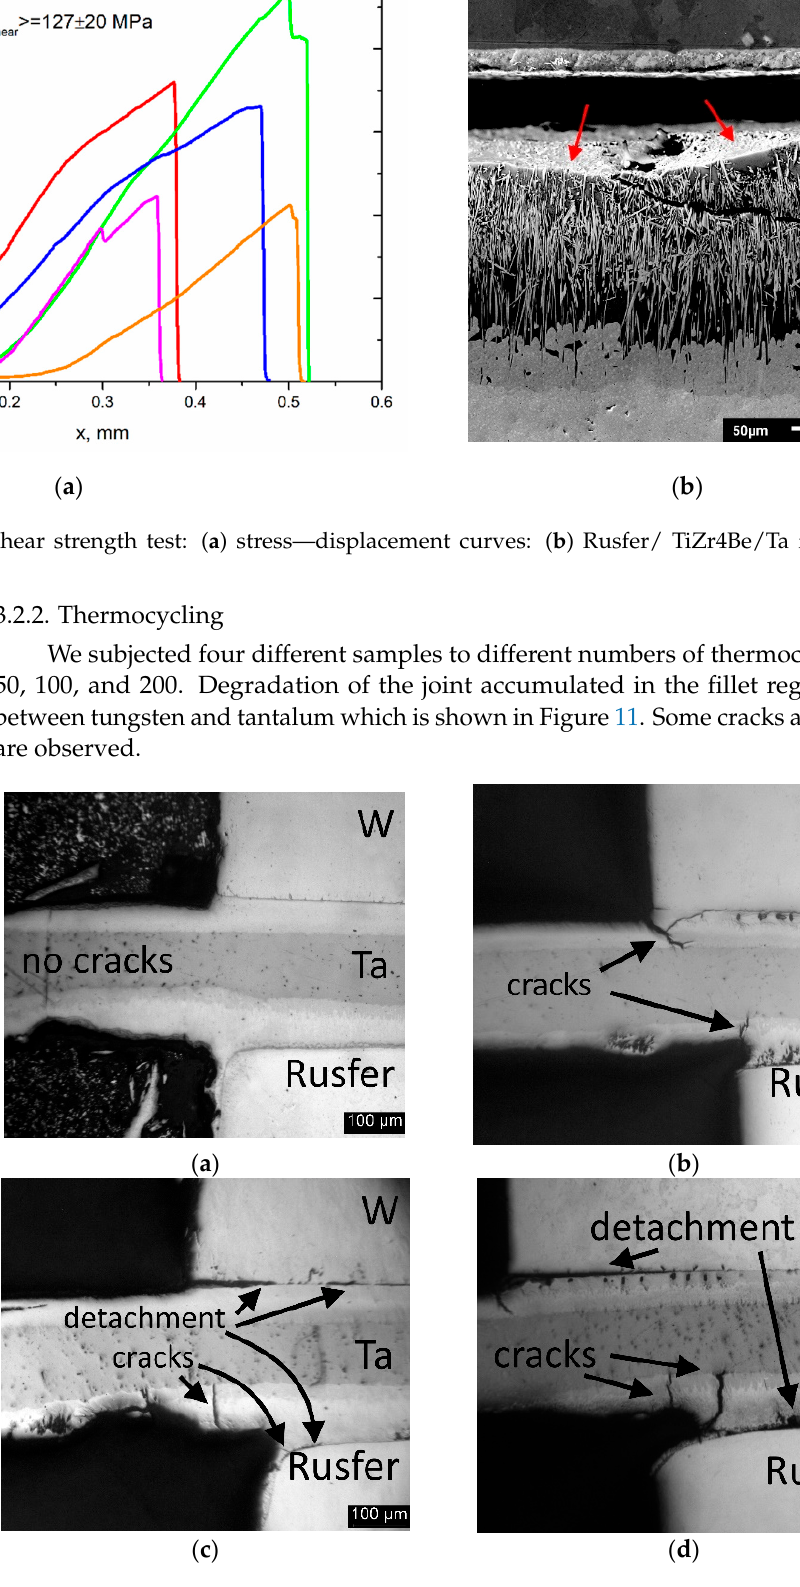
Figure 11. Optical image of the fillet region of the samples after thermocycling between 300–600 °C: ( a )—as-joined, ( b )—50 thermocycles, ( c )—100 thermocycles, ( d )—200 thermocycles.